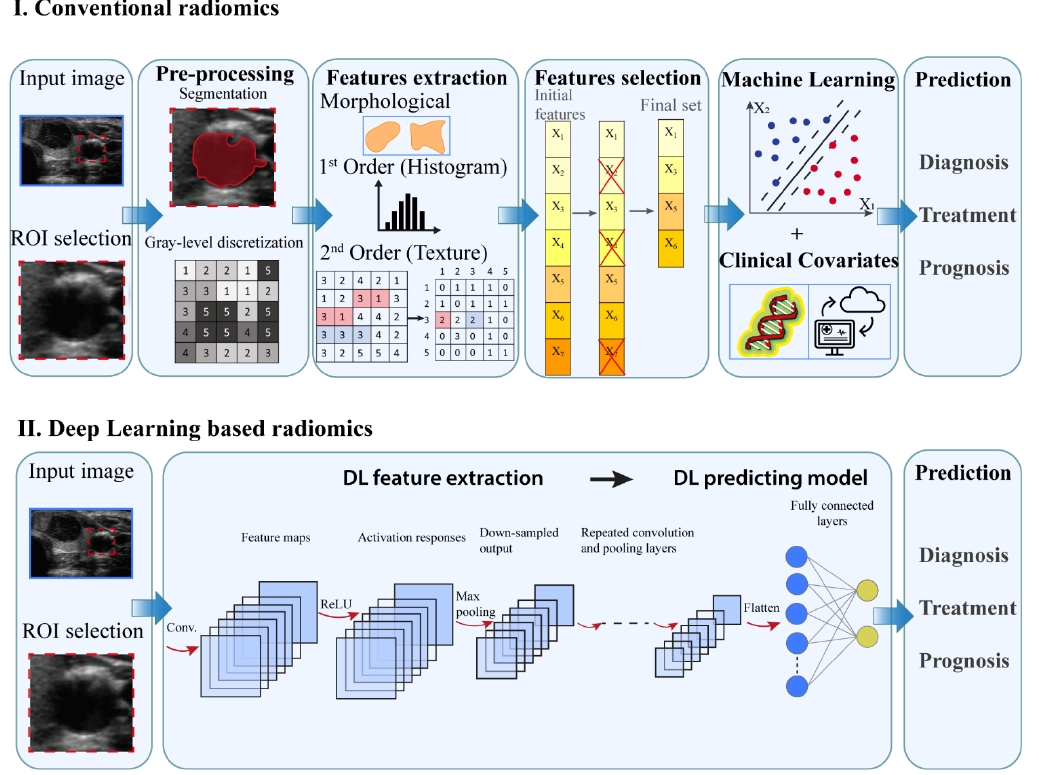
Figure 4. Schematic flowchart of radiomics approach. X i represent the feature extracted from the image data.